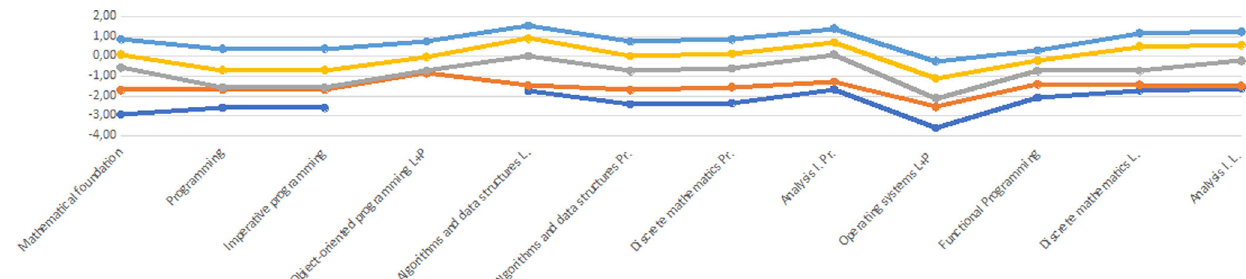
Fig. 1 Dif fi culty levels of the subjects in 2018 and 2019 academic